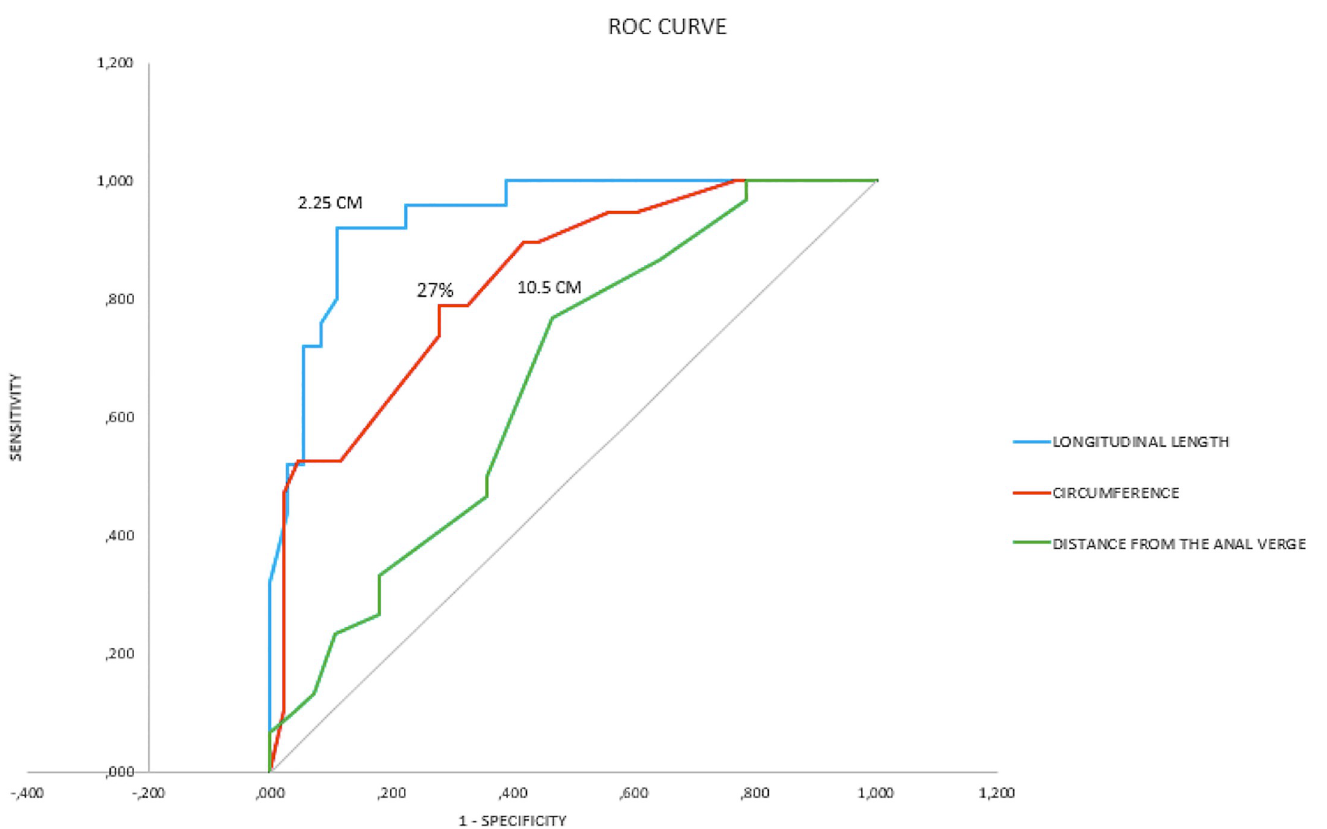
Fig 7. Graph of ROC curves of the circumference of the affected loop, intestinal nodule size and distance from the anal verge with the respective cutoff points separating linear nodulectomy from segmental